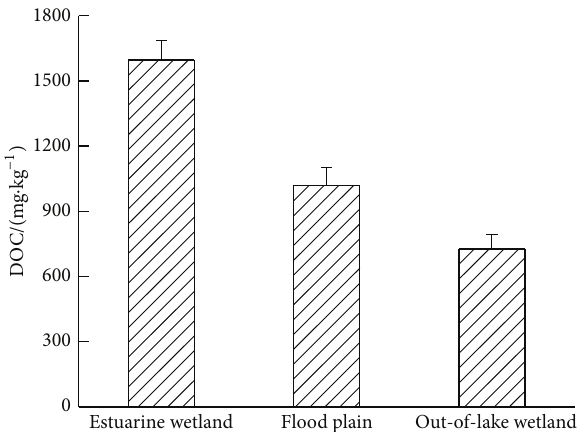
Figure 4: Changes of LOC content under different types of wetland in Hongze Lake of